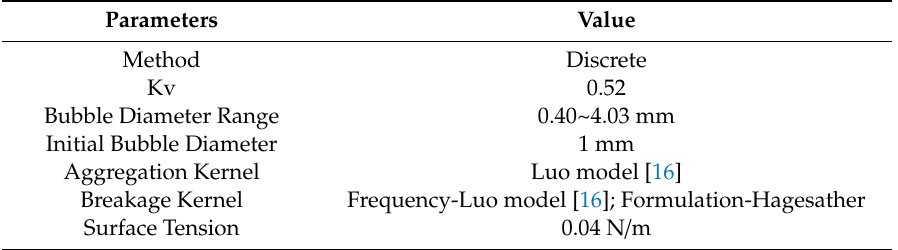
Figure 2. Geometry and boundary conditions of the flotation column for simulation. Table 1. The parameters of population balance model (PBM).